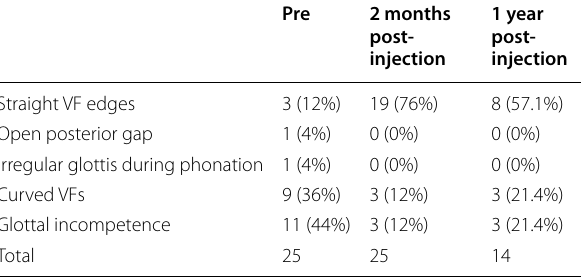
Table 2 Glottal closure: assessment of the glottal gap on the base of